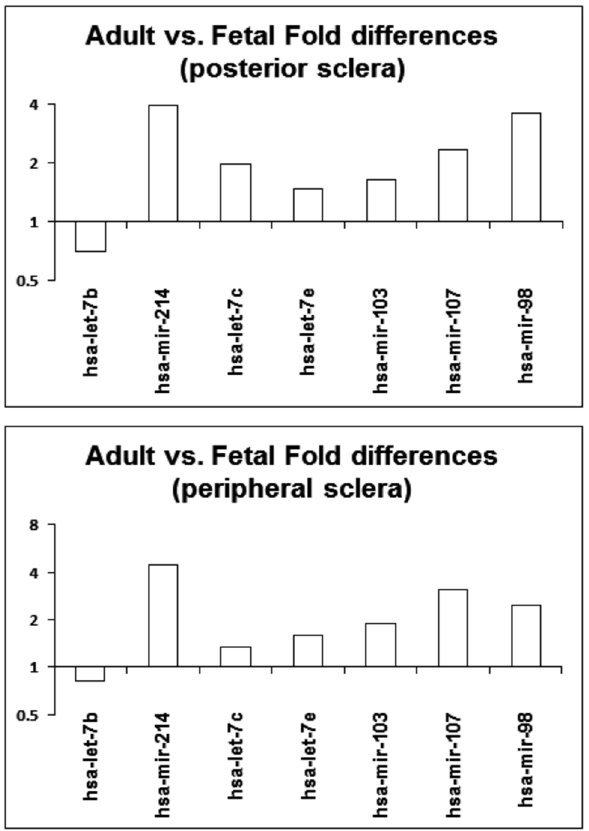
Figure 4. Results from Taqman micro-RNA PCR assays. (Top) Relative fold changes in micro-RNA expression in adult compared to fetal posterior sclera (n=7); all micro-RNAs except miR-let7-b were significantly up-regulated in fetal compared to adult samples. (Bottom) Relative fold changes in micro-RNA expression in adult compared to fetal peripheral sclera (n=7); all micro-RNAs except hsa-let7b and hsa-let7c were significantly up-regulated in fetal compared to adult samples. (Y-axis in log scale to the base 2).